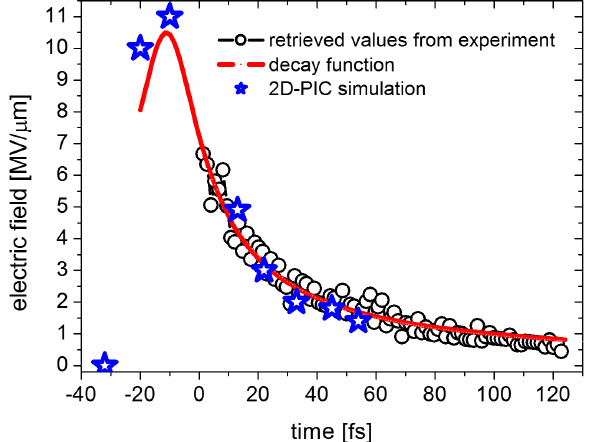
FIG. 6. Evaluated decrease of the acceleration field strength (black circles) from the experimentally obtained density modu- lation in the energy distribution of protons (cf. Fig. 1 — 90 signal maxima of the proton EDF); the red curve represents a nonlinear fit with a decay function (cf. the text) and blue stars results from 2D-PIC simulations (cf. the